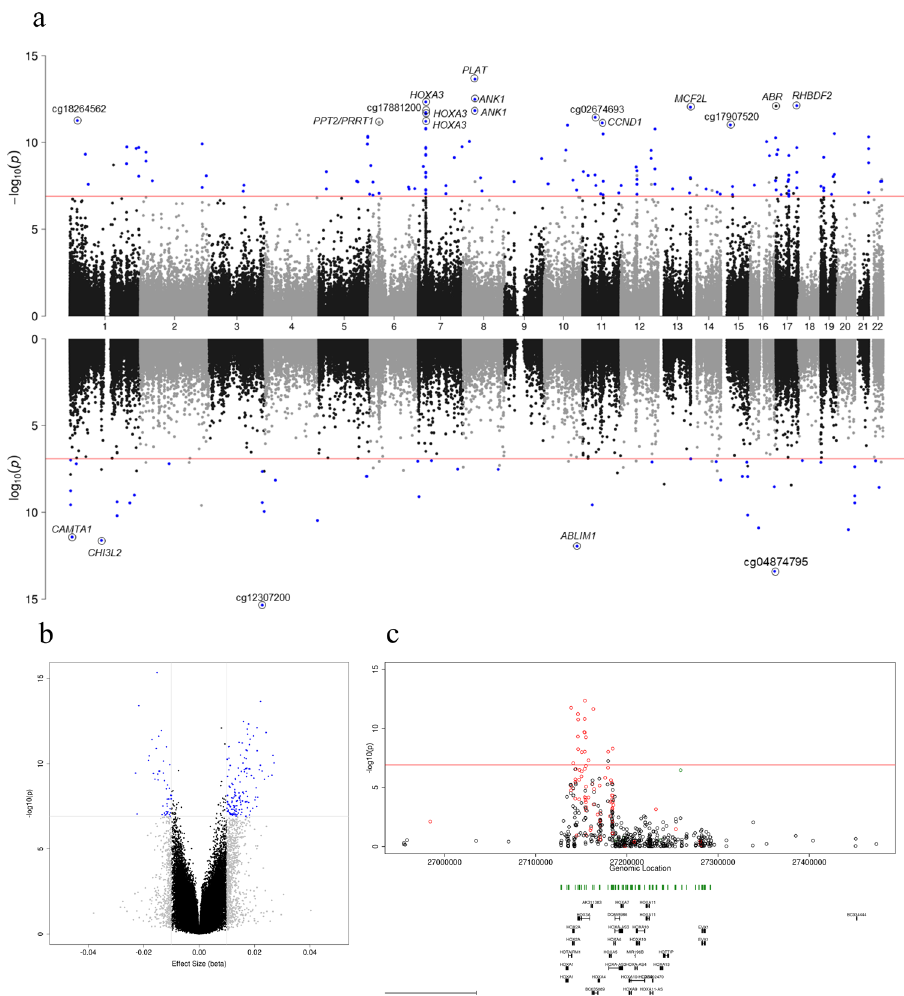
Fig. 2 A cross-cortex meta-analysis identi fi es 220 Bonferroni signi fi cant differentially methylated positions (DMPs) associated with Braak stage. a A Miami plot of the cross-cortex meta-analyses ( N = 1408). Probes shown above the X -axis indicate hypermethylation with higher Braak stage, whilst probes shown below the X -axis indicate hypomethylation with higher Braak stage. The chromosome and genomic position are shown on the X -axis. The Y -axis shows – log10( p ). The red horizontal lines indicate the Bonferroni signi fi cance level of P < 1.238 × 10 − 7 . Probes with a methylation (beta) effect size (ES: difference between Braak 0- Braak VI) ≥ 0.01 and P < 1.238 × 10 − 7 are shown in blue. The 20 most signi fi cant DMPs are circled on the plot and Illumina UCSC gene name is shown if annotated, or CpG ID if unannotated. Exact P values can be found in Table 2 and Supplementary Data 7. b A volcano plot showing the ES ( X -axis) and – log10( p ) ( Y -axis) for the cross-cortical meta-analysis results. Grey probes indicate an ES between ≥ 0.01, whilst blue probes indicate an ES ≥ 0.01 and P < 1.238 × 10 − 7 . c The most signi fi cant cross-cortex differentially methylated region (DMR) (chr7:27153212 – 27154305) contained 11 probes and resided in the HOXA region. The horizontal red line denotes the Bonferroni signi fi cance level of P < 1.238 × 10 − 7 . Red probes represent a positive ES ≥ 0.01, blue probes represent a negative ES ≥ 0.01. Underneath the gene tracks are shown in black with CpG islands in